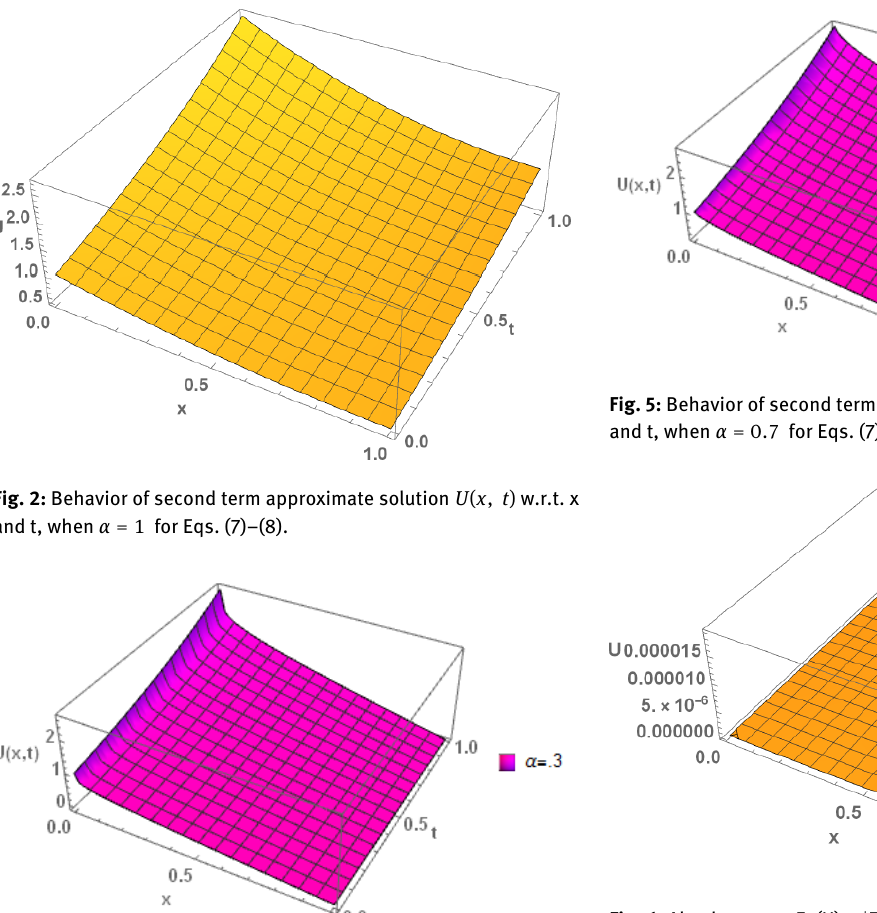
Fig. 6: Absolute error E 8 (U) = | Exact – Approximate value | for Eqs. (7) – (8).